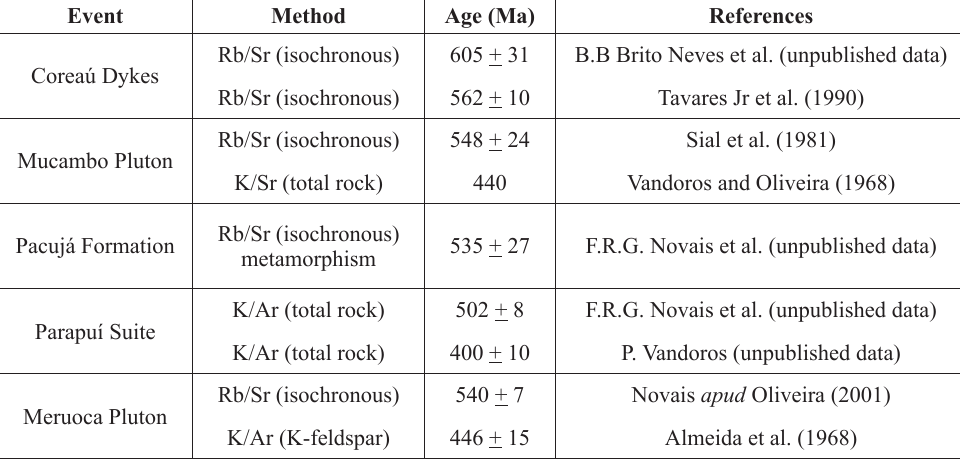
Geochronological data for the major sedimentary and magmatic events of the Jaibaras Basin, indicating the minimum and the maximum value of each